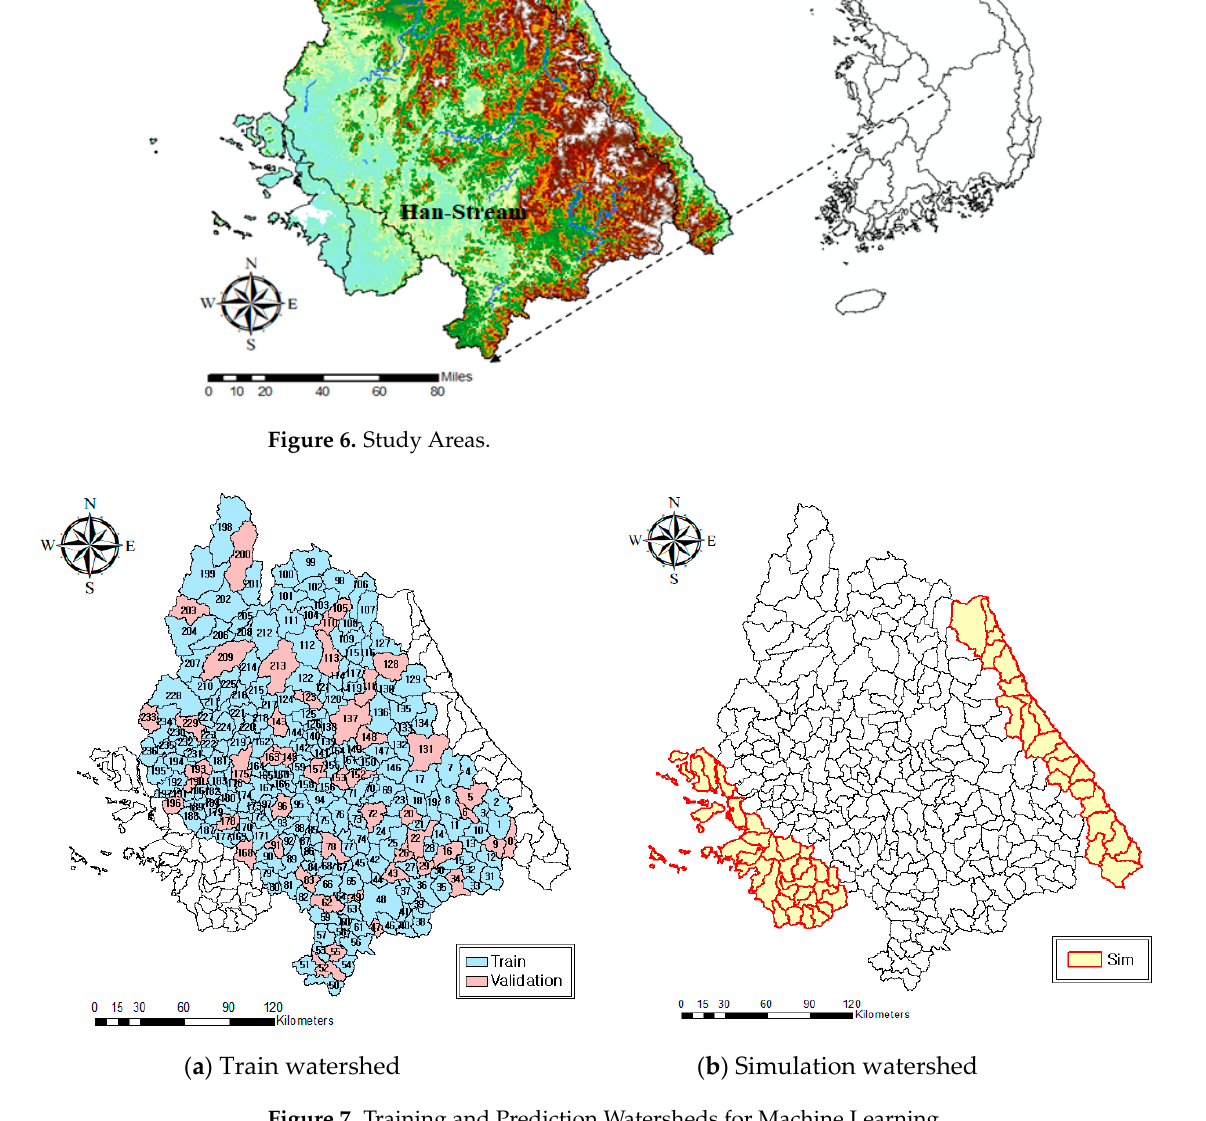
Figure 7. Training and Prediction Watersheds for Machine Learning.